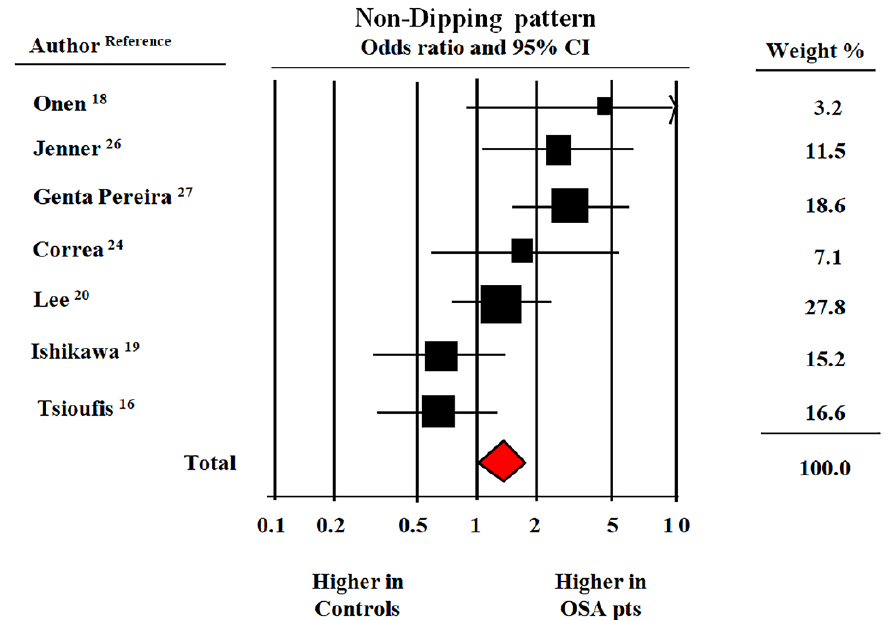
Figure 3. Odds ratio of the non-dipping pattern during 24-hour blood pressure monitoring in patients with obstructive sleep apnea vs. without obstructive sleep apnea (OSA) [16,18 – 20,24,26,27]. Data from seven studies and 1330 participants with and without OSA. Fixed model ( I 2 = 56%).